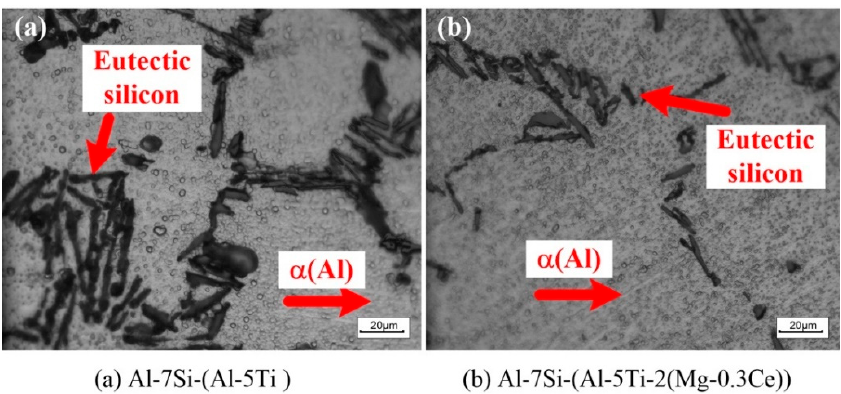
Figure 9. Metallographic microscope image of the Al–Si alloy (500×).